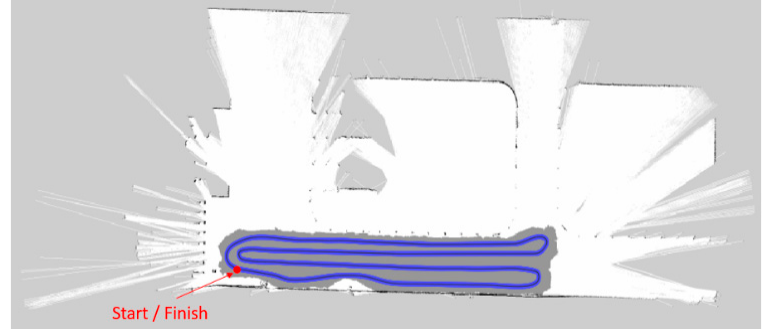
Figure 9. Experimental background and pre-defined path, top down view.